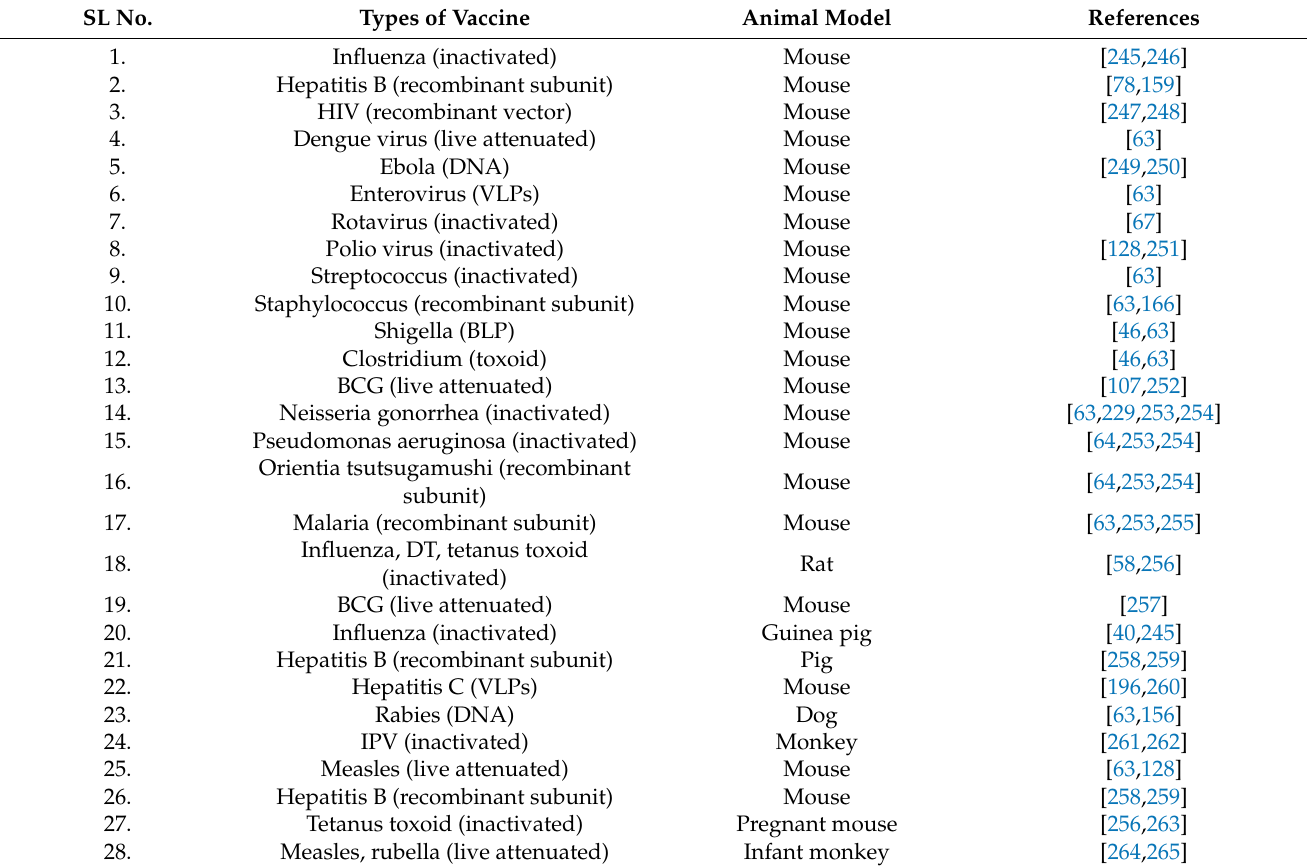
Table 6. Model animals and vaccines for dissolving microneedle array patches